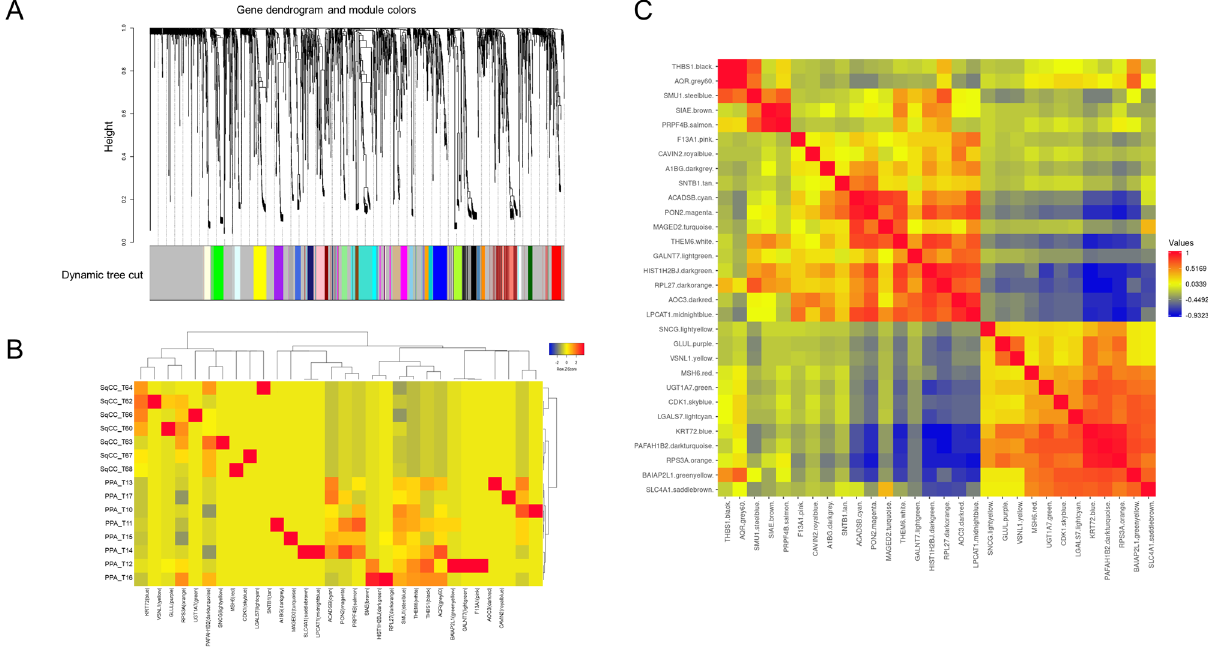
Figure 2. Protein network modules identified by weighted gene co-expression network analysis (WGCNA). ( A ) Protein dendrogram obtained by clustering the dissimilarity based on consensus topological overlap with the corresponding module. Colored rows correspond to the 30 modules identified. ( B ) Heatmap of semiquantitative expressions of module eigen proteins with samples. ( C ) Pairwise correlations between the modules in the heatmap of eigen proteins in module